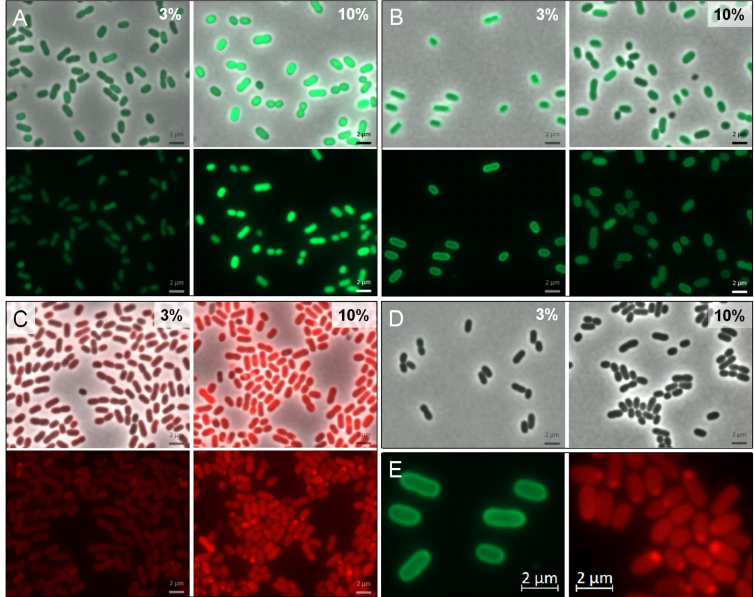
Figure 5. Imaging of cytoplasmatic and periplasmatic expression of GFPuv and mCherry in H. elongata . Cells were either grown at constant salinity in MM63-3% or grown in MM63-3% and shocked